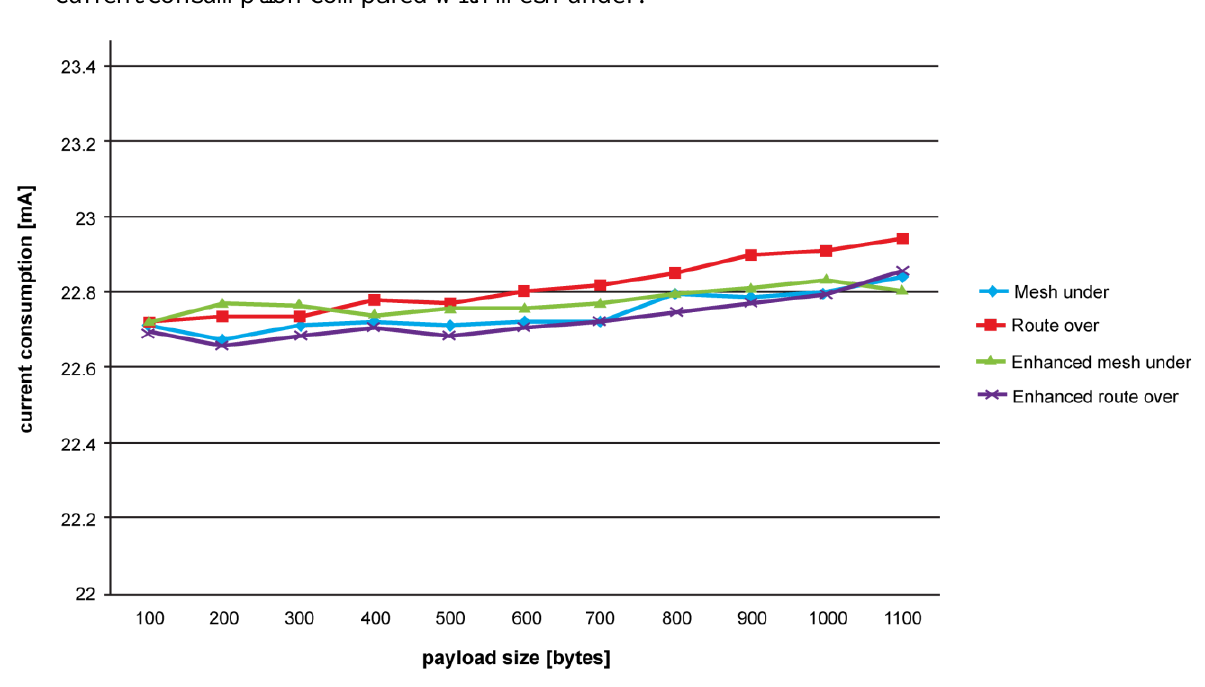
Figure 6. Current consumption evolution according to ICMP payload size. Hop-by-hop fragment reassembling performed by route over proves to be energy demanding. The control on packet forwarding introduced in controlled mesh under, slightly increases current consumption compared with mesh